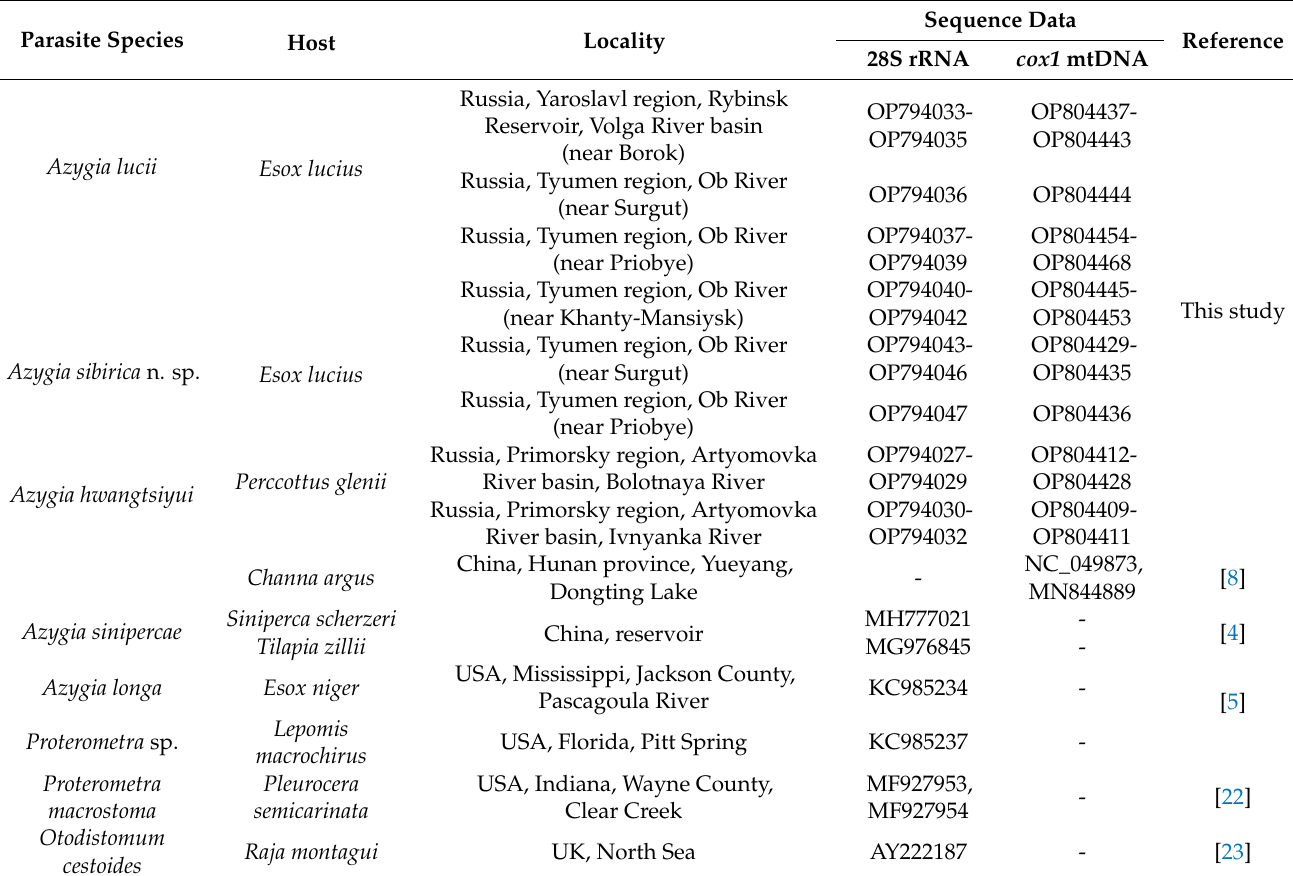
Table 1. Information on the azygiid species names, hosts, and accession numbers for the partial se- quences of the 28S rRNA and cox1 mtDNA genes, downloaded from GenBank for phylogenetic